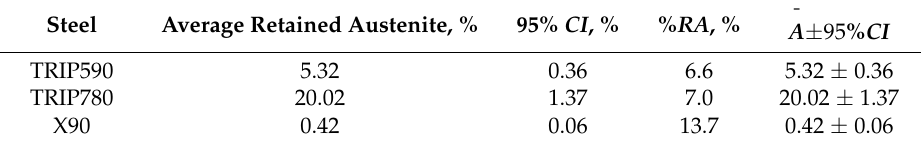
Table 9. The measured retained austenite content in three steels by the EBSD method.